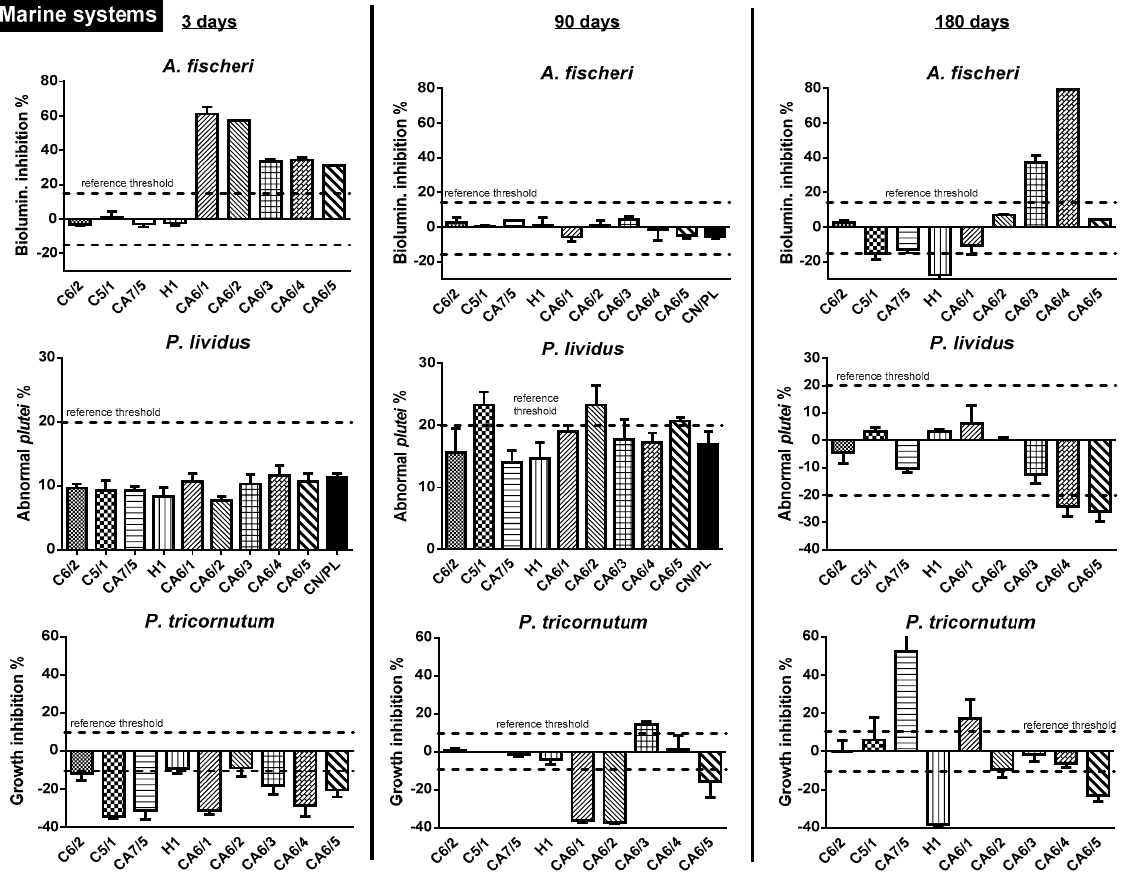
Figure 2. Biological responses of the different model species exposed to glitter leachate in saltwater according to the different soaking times: 3, 90 and 180 days. The dashed line refers to the reference threshold established by the method (15% for A. fischeri ; 20% for P. lividus ; 10% for P. tricornutum) . Negative controls in plastic containers (CN/PL) are shown in black-fill pattern (if not present, data